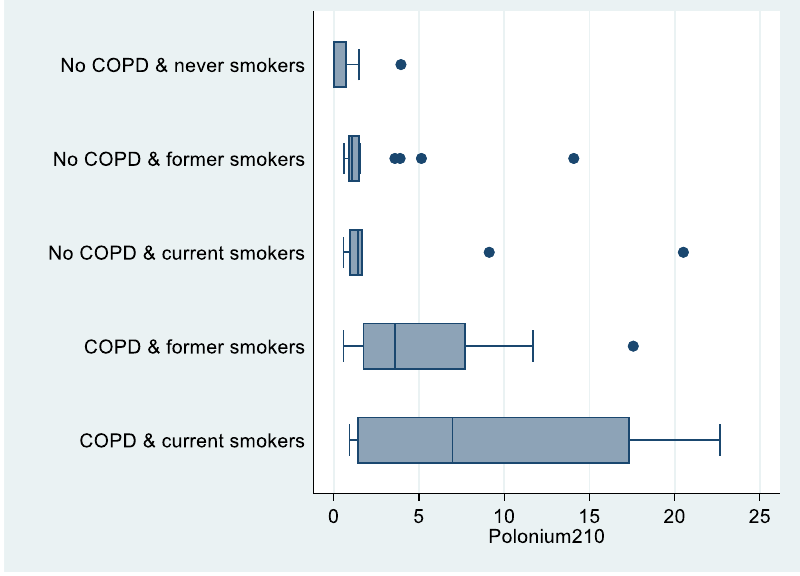
Figure 3. Box plot of polonium-210 (in mBq) by COPD and smoking status, “Polonium in vivo” study ( n = 49; 21 missing). The left and right borders of the box are the lower and upper quartiles; the solid line in the box is the median. The “whiskers”, that is, the lower and upper adjacent values, are used for identifying extreme values in the tails of the distribution. Dots greater than the upper adjacent value represent outliers.